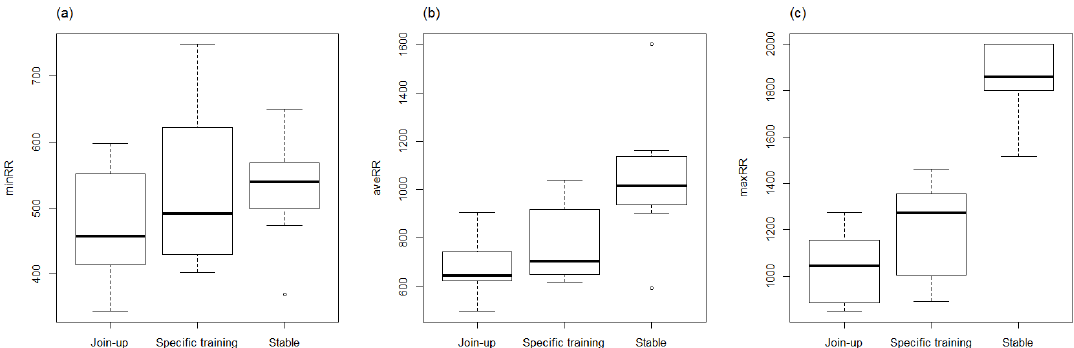
Figure 4. Minimum ( a ), average ( b ), and maximum ( c ) beat-to-beat (RR) intervals (ms) of horses before training (Stable), during their first Join-Up ® (Join-up) and during the rest of the training session (Specific training). RR intervals were significantly lower in Join-up ® ( p = 0.007) than in specific training. Analysed using generalized linear mixed models (GLMM).